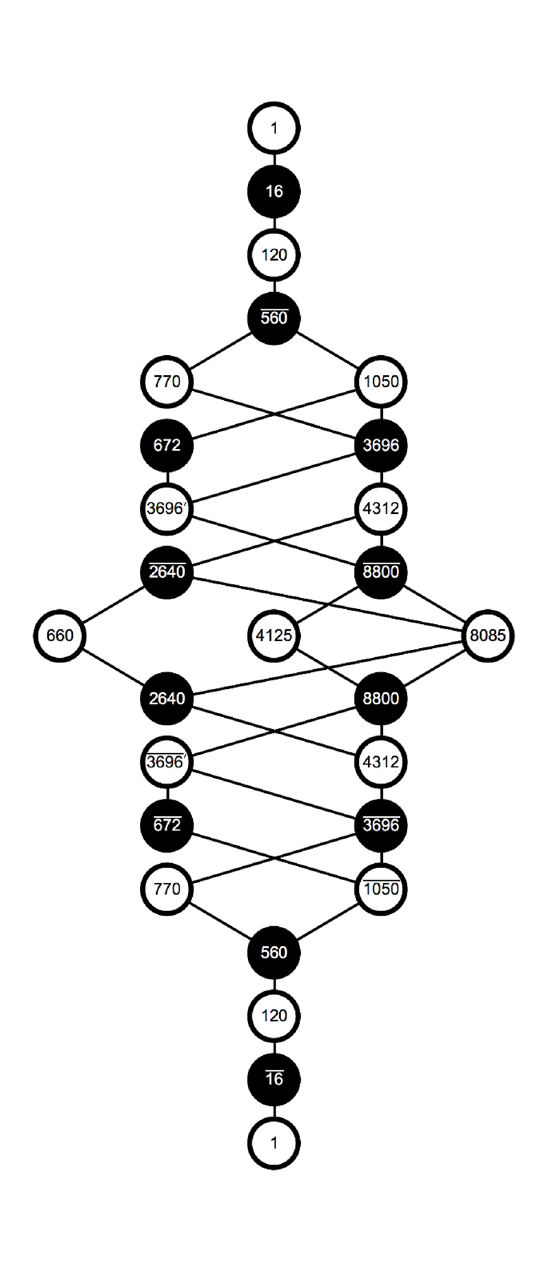
Figure 1. Adinkra Diagram for 10D, N = 1 Scalar